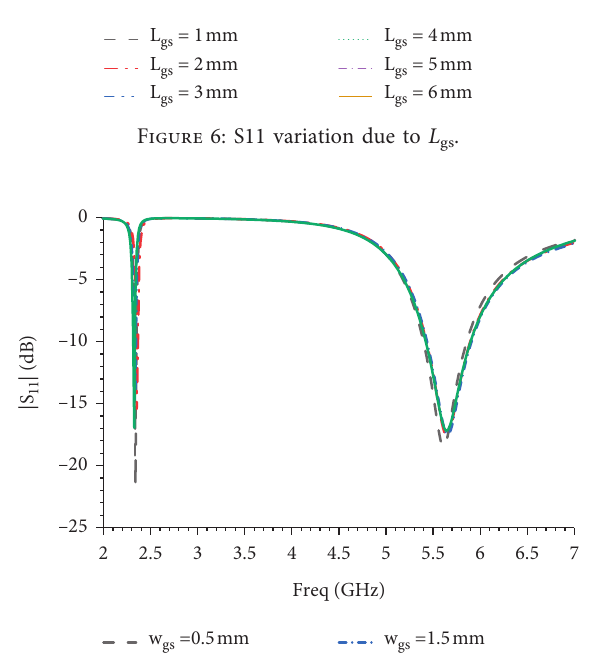
Figure 7: S11 variation due to w